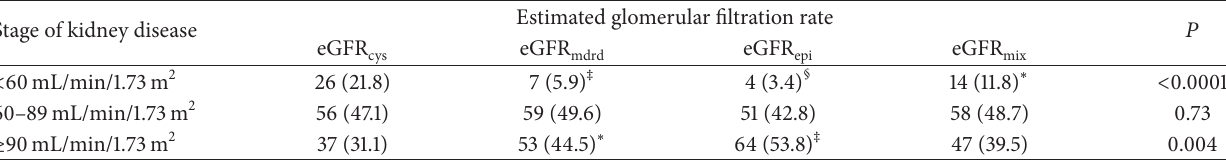
Table 3: Prevalence by categories of eGFR according to the stages of chronic kidney disease, for equation to estimate the GFR. Stage of kidney